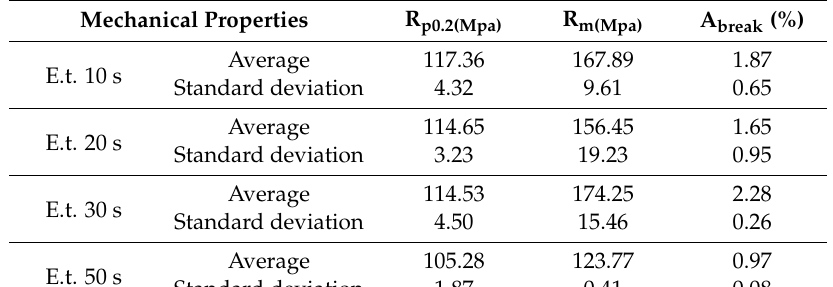
Figure 3. Mechanical properties obtained after tensile tests. Table 2. Mechanical properties obtained with tensile tests. (E.t. = elapsing time).